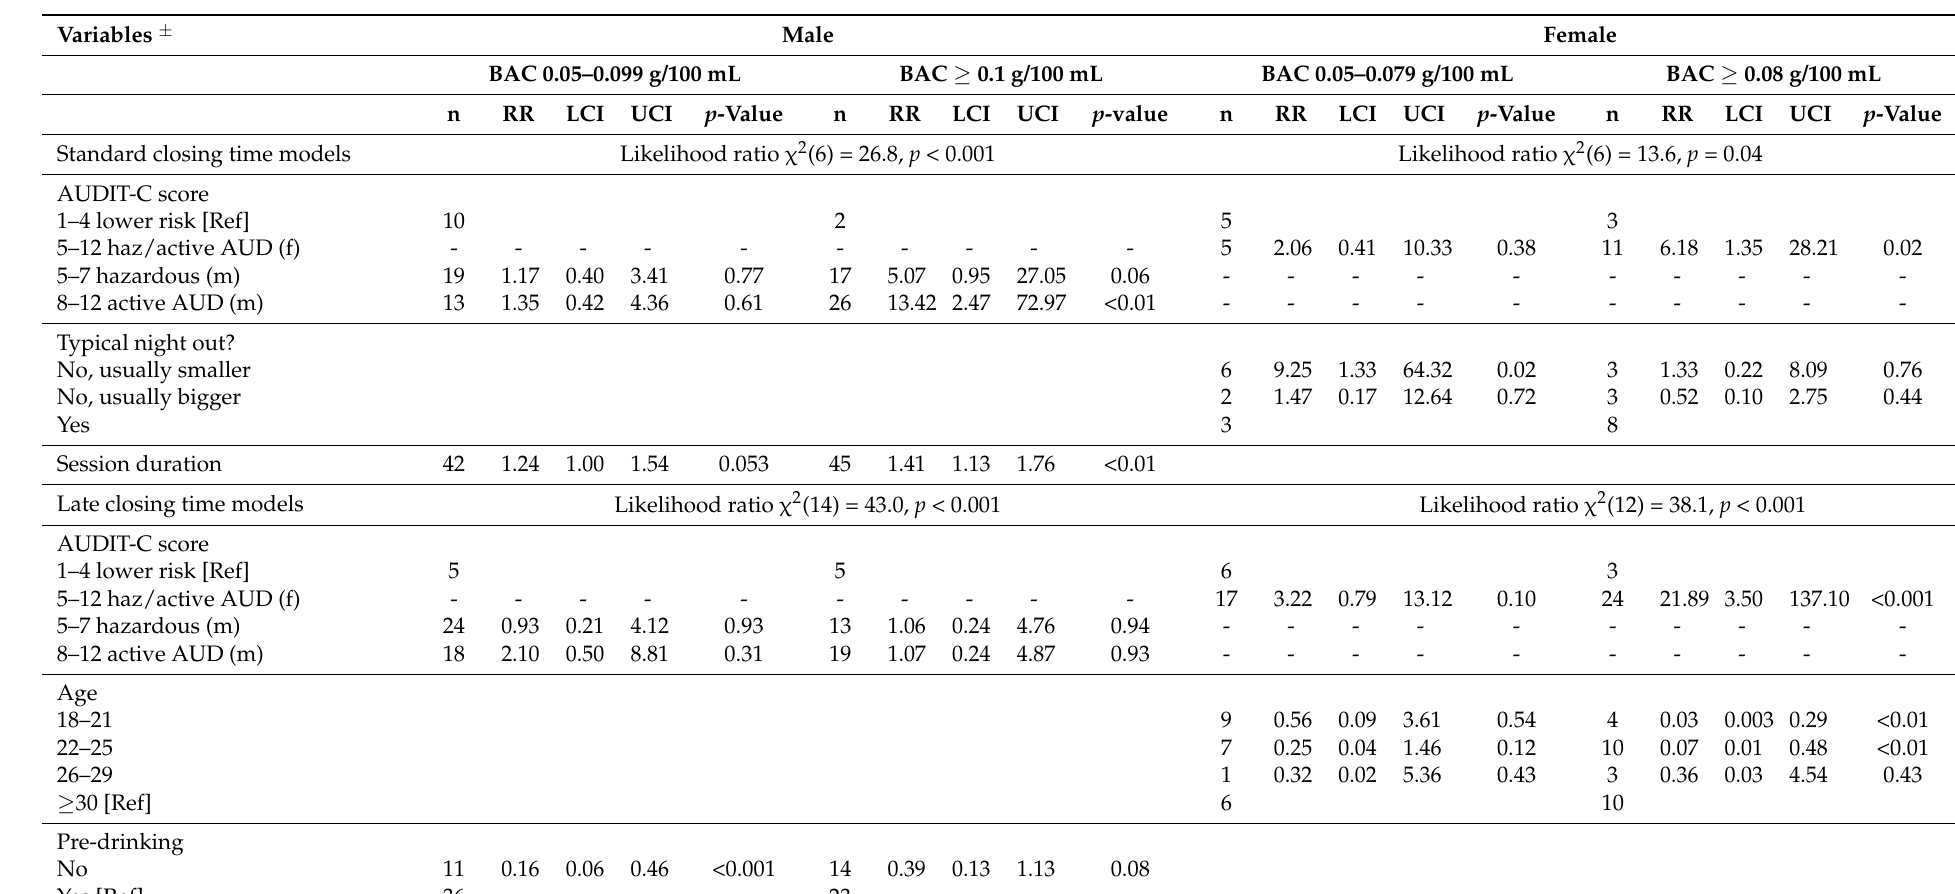
Table 2. Gender-specific multinomial logistic regression models: Association between participant AUDIT-C and BAC by preferred bar type (standard, late, total) adjusting for survey and participant characteristics ±